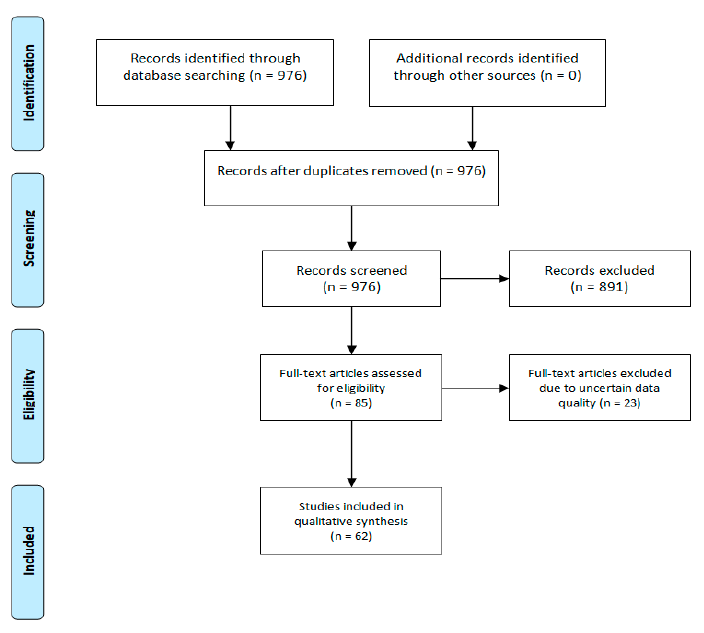
Figure 1. Flow diagram of the review.